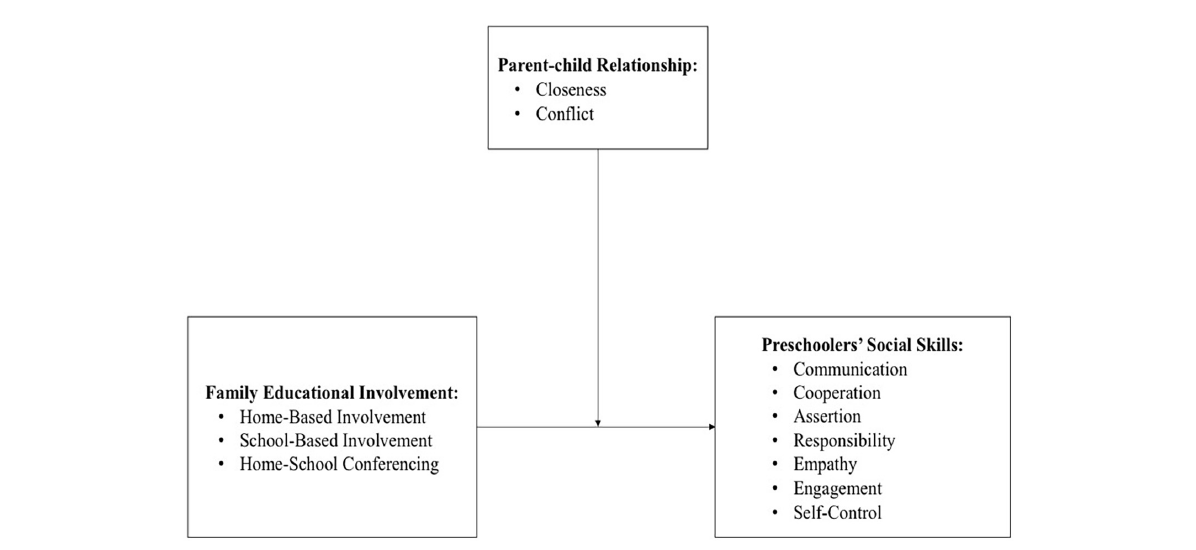
FIGURE1 Conceptual model of the relation between family educational involvement, parent-child relationship, and social skills among preschoolers.